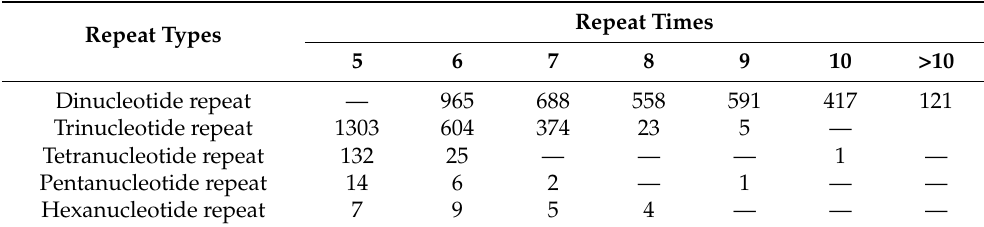
Table 4. Number of SSRs of different repeat motifs on different repeat times in the flower transcrip- tome of L. yunnanensis